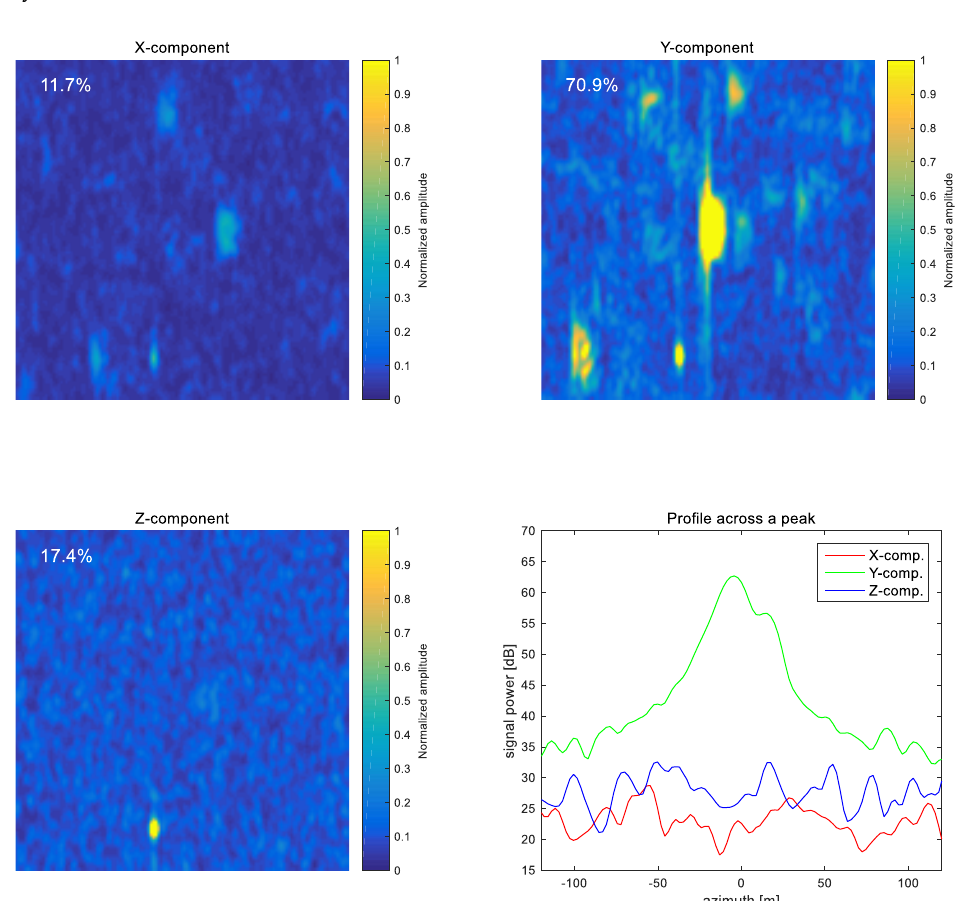
Figure 5. Three different views computed from the sub-area containing ghosts in Figure 3b. The positive high-frequency component was assigned to the X-axis ( upper left ), the negative high-frequency component was assigned to the Y-axis ( upper right ), and the low Doppler frequency component was assigned to the Z-axis ( bottom left ). The summed signal powers of the X- and Z-components account only for 11.7% and 17.4% of the total signal power, respectively, while the signal power is concentrated on the single dominant Y-component, 70.9%. Azimuth profiles across the brightest peak were compared ( bottom right ), and the maximum peak powers of the X- and Z-components were found to be insignificant and lower than that of the Y-component by about 35 dB.